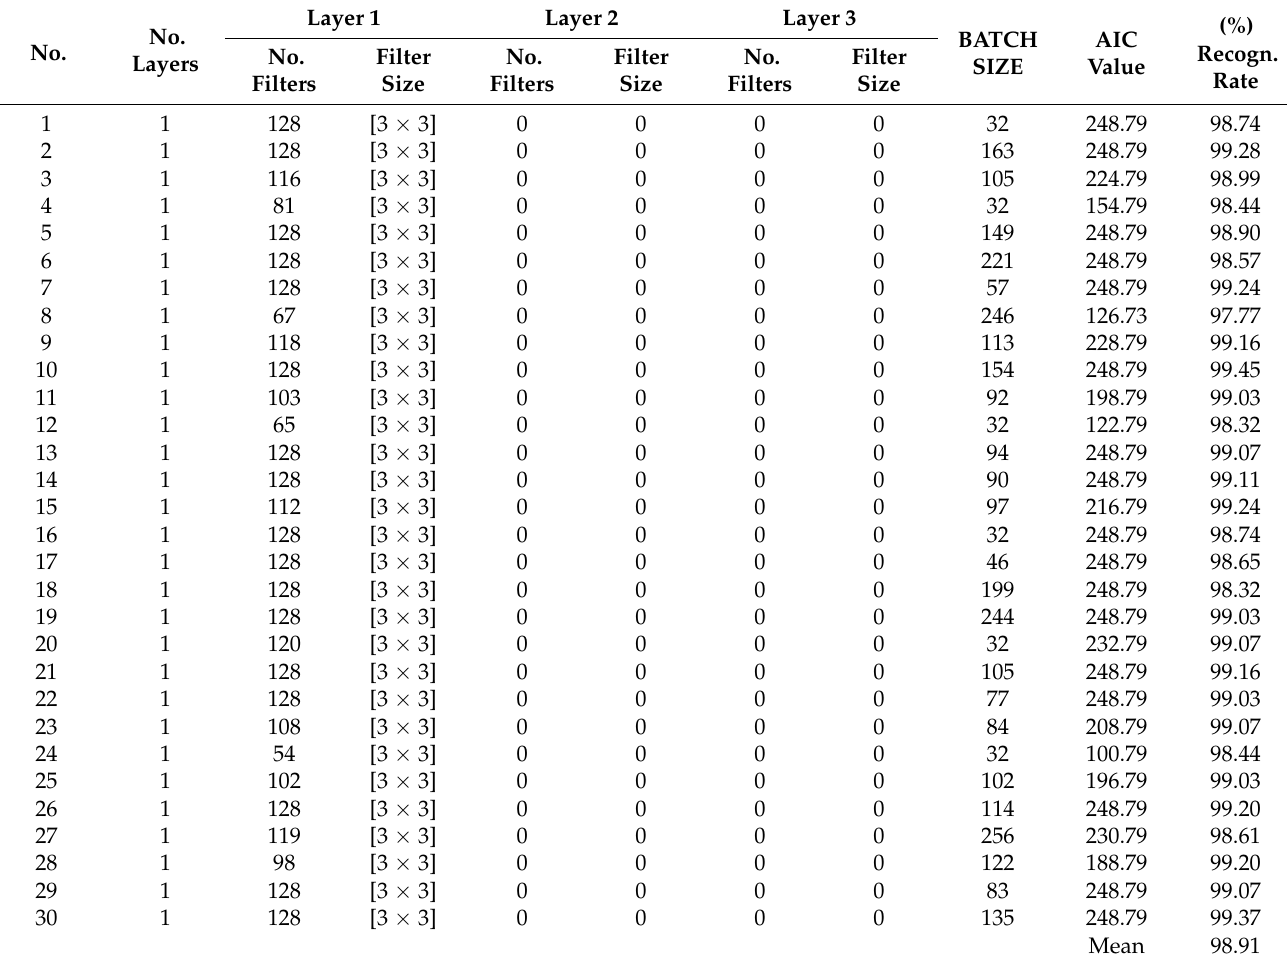
Table 14. Results achieved by the PSO-CNN-II in MSL alphabet.